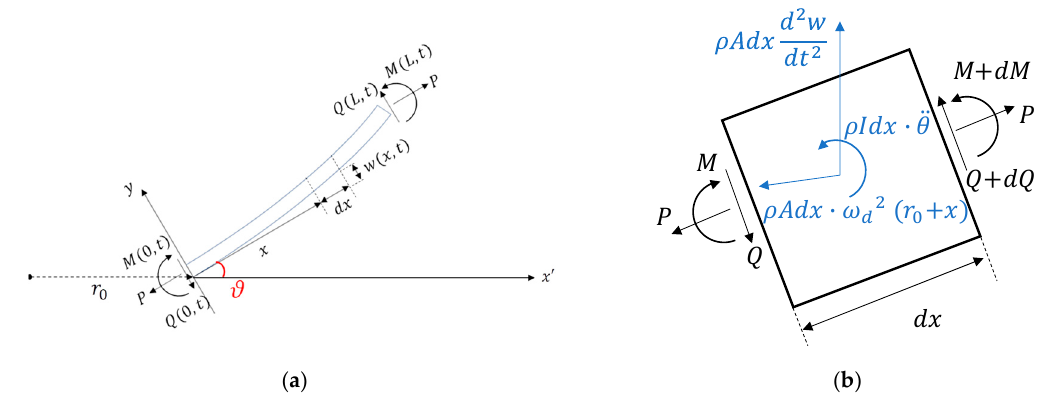
Figure 2. Schematic of the PEH.